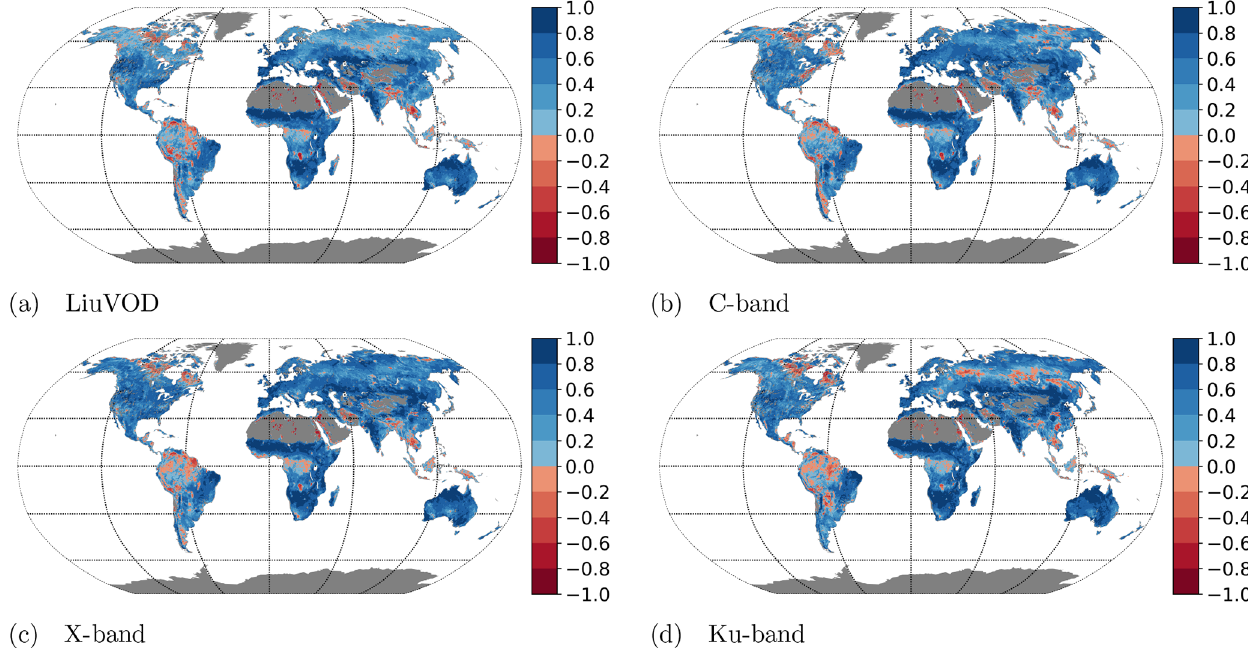
Figure 12. Correlation of monthly VOD_Liu and the VODCA products with MODIS LAI. For this analysis, the data are first resampled to monthly averages, and then only the months where all four data sets have values are